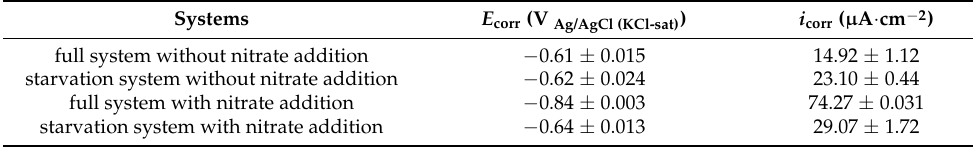
Figure 9. PDP curves on EH40 steel after 14 days of immersion in different systems. Table 3. Electrochemical parameters derived from PDP curves.